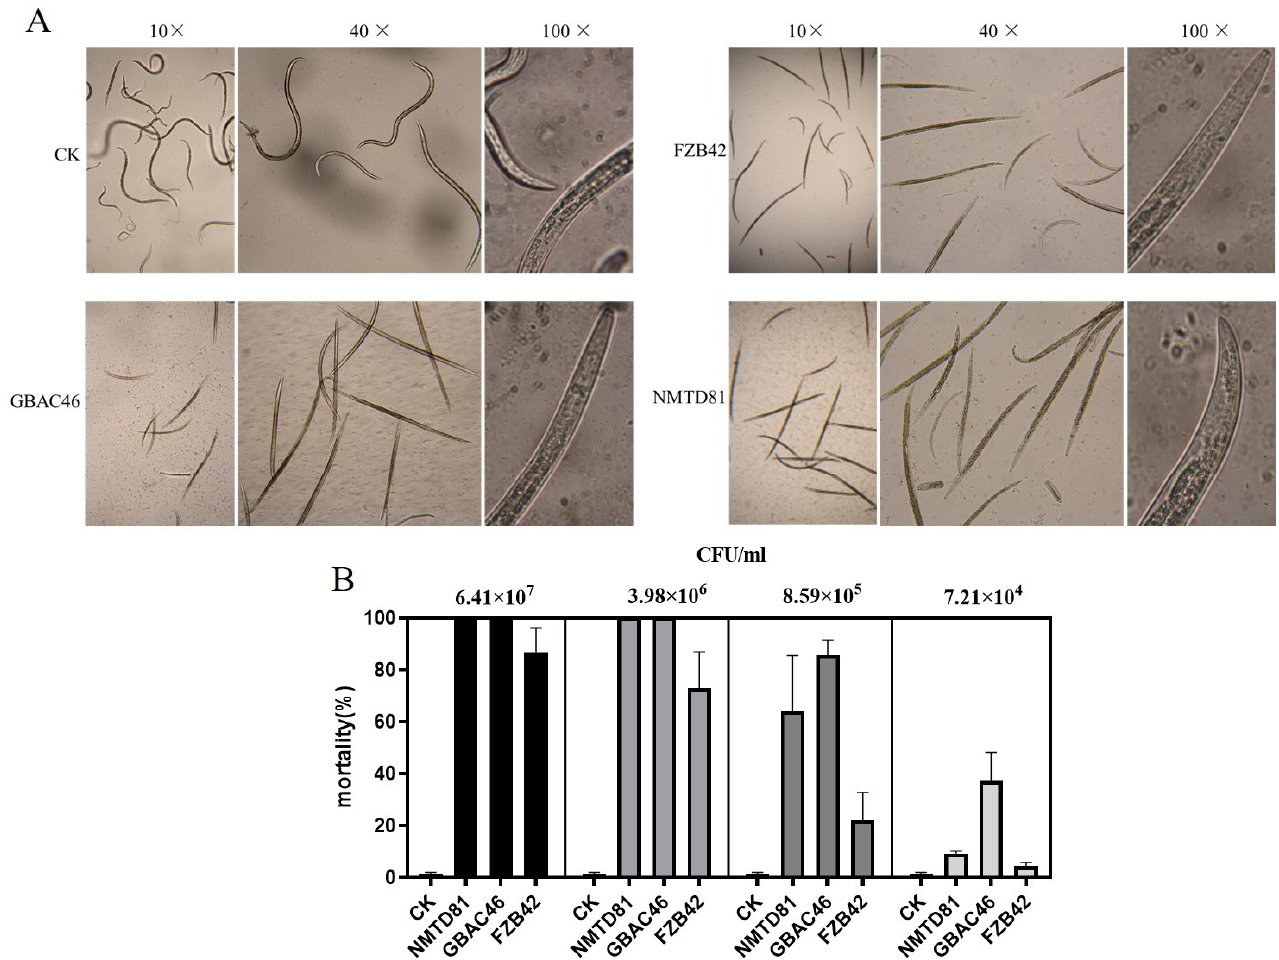
Figure 3. Nematicidal activity of selected Bacillus strains against A. besseyi compared with the control: ( A ) microscopic figures under different objectives: 10×, 40×, and 100×; ( B ) graphical details of the nematicidal activity of selected Bacillus strains. Different error bars show the different mean standard deviation of each treatment repeated three times with triplicates.